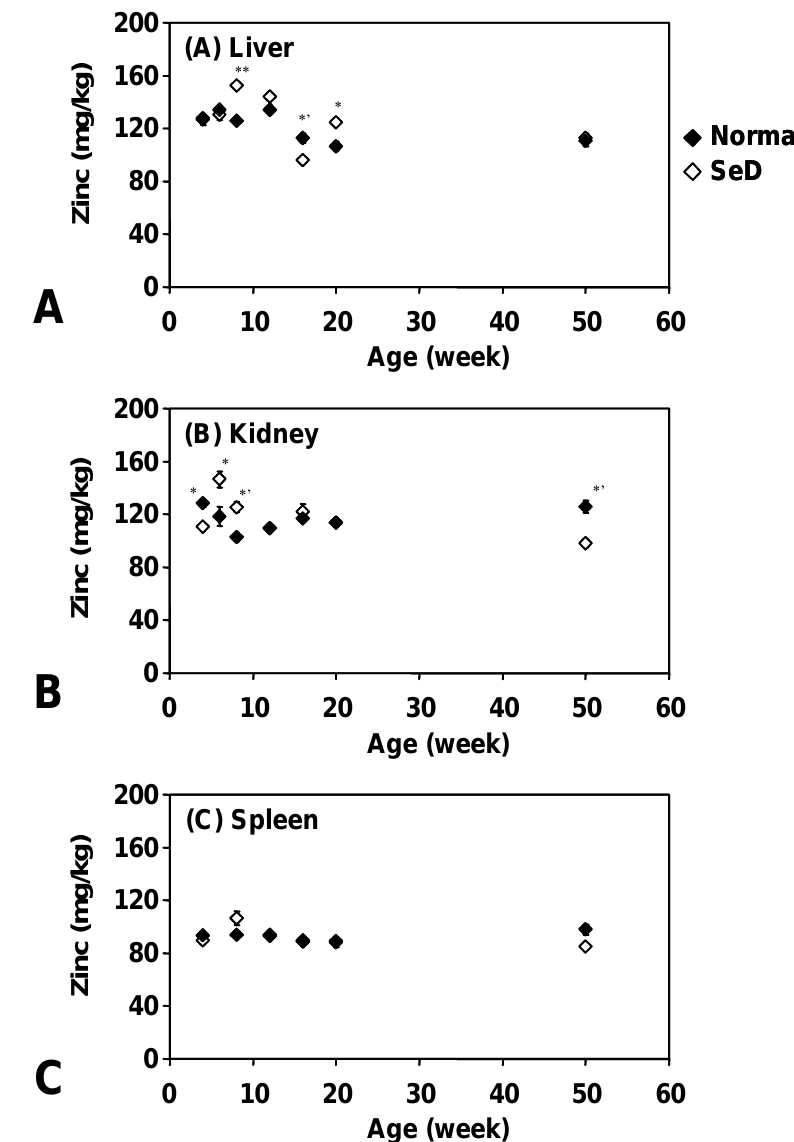
Figure 5. Dependence of Zn contents in the (A) liver, (B) kidney, and (C) spleen of normal and SeD rats on the age of rats. Values are indicated as the mean ±SD of three measurements. * , *’ , and ** indicate significant difference between normal and SeD groups at p < 0.05, p < 0.01, and p < 0.001,